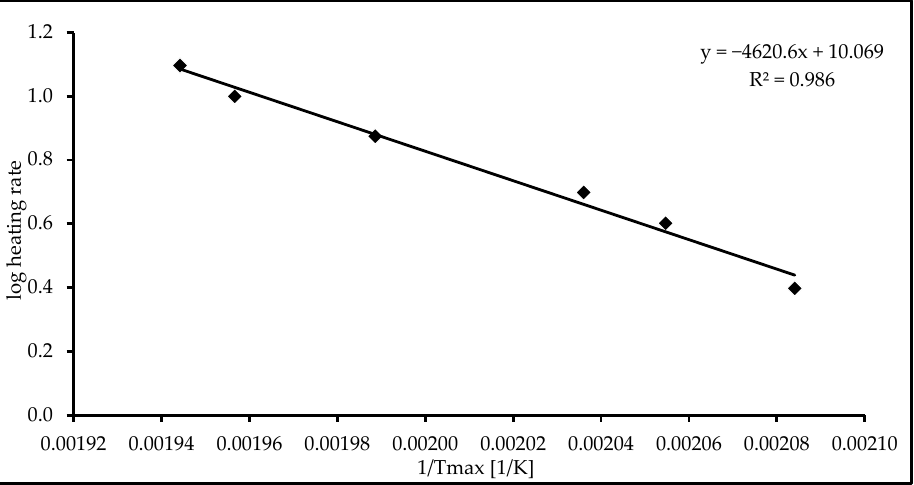
Figure 5. Temperature shift at the maximum (of the oxidation process) of DSC curves depending on the logarithm of heating rate of the thermo ‐ oxidative decomposition of silverskin fat. The dependencies shown in Figures 4 and 5 can be described by a regression equation: